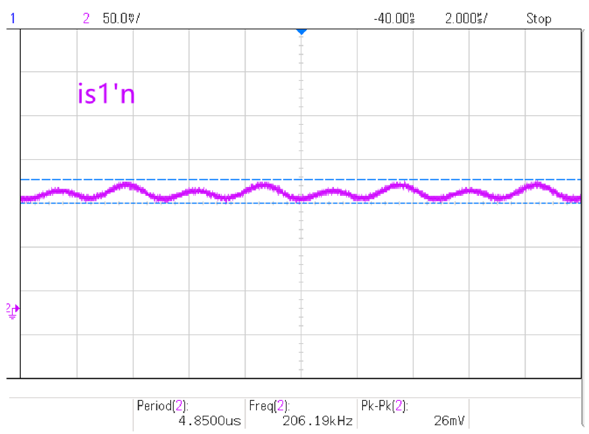
Figure 26. IDC static 180° phase-shifting input phase-current waveform.